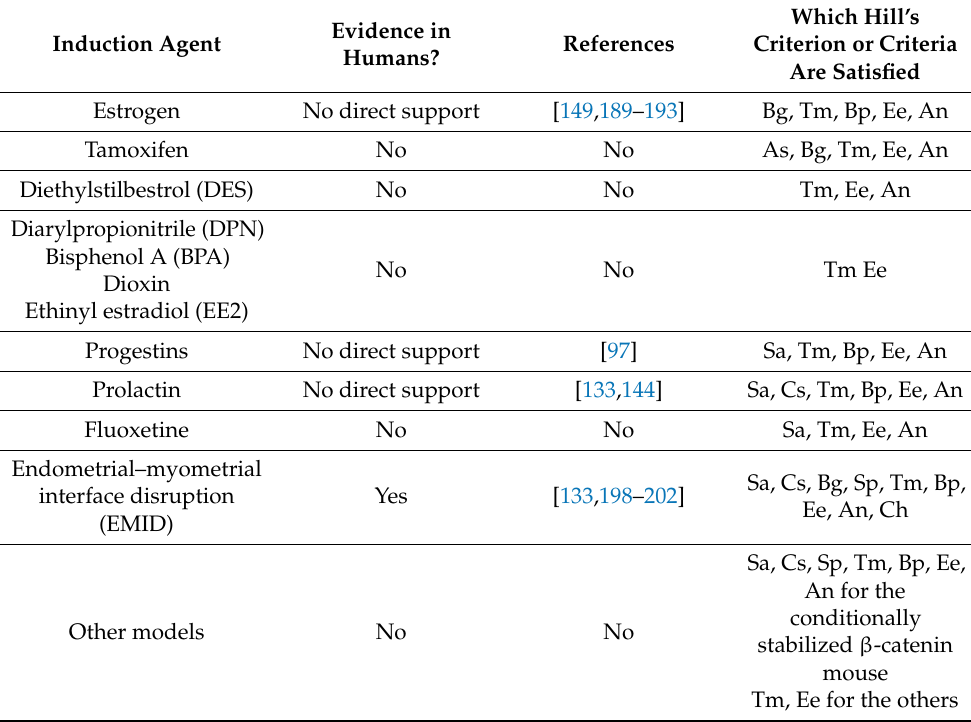
Table 3. A summary of epidemiological data in support for animal models of adenomyosis and which criterion of Austin Bradford Hill’s criteria for establishing causality are